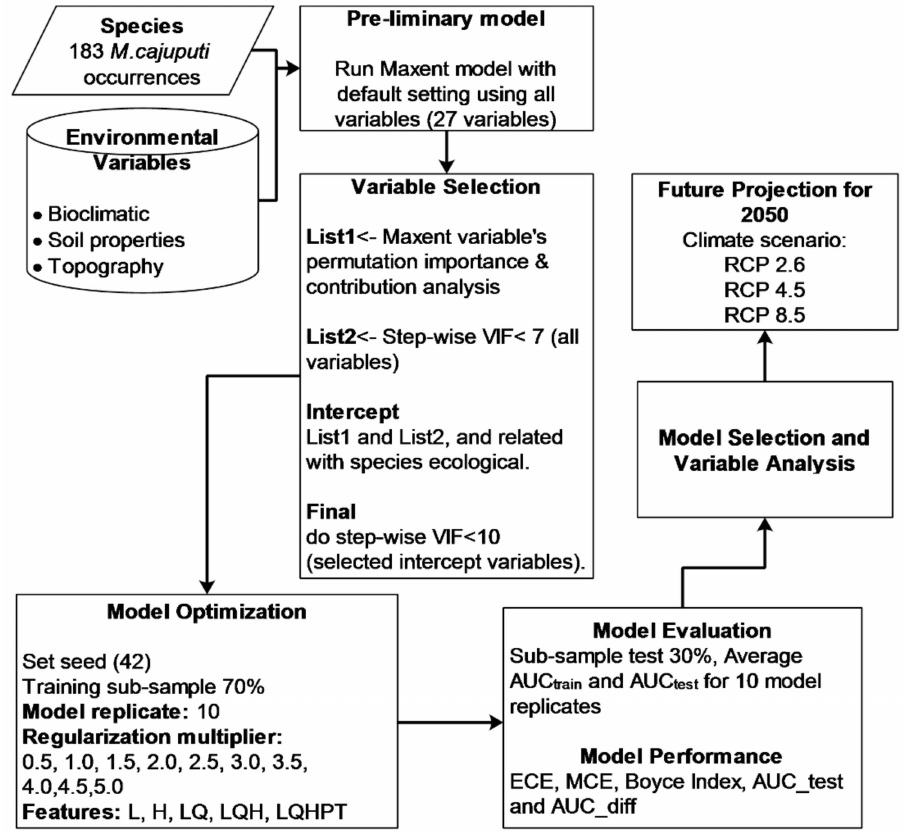
Figure 2. M. cajuputi habitat suitability modeling